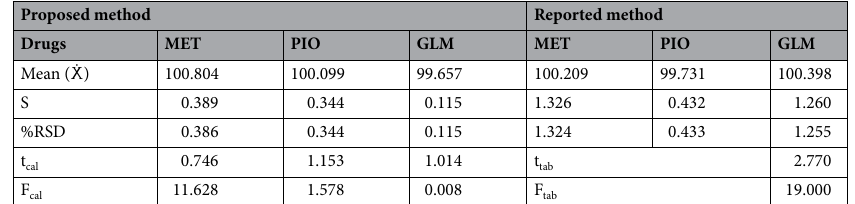
Table 4. Comparison between the assay of prepared tablets using the proposed HPLC method and reported method. X: Mean of % recoveries; S.D: standard deviation; R.S.D: relative standard deviation; t cal : calculated t-value; t tab : tabulated t-value; F cal : calculated F-value; F tab : tabulated F-value.